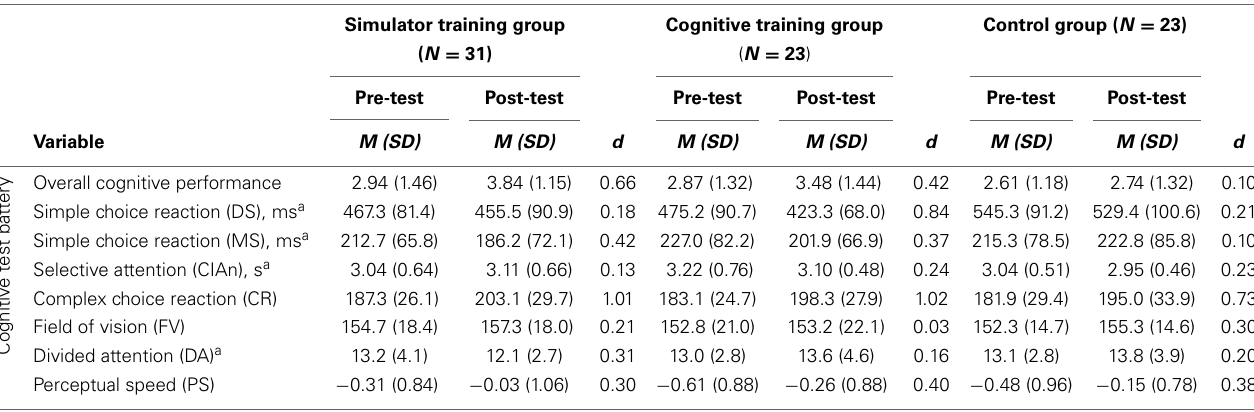
Table 9 | Descriptive statistics for cognitive